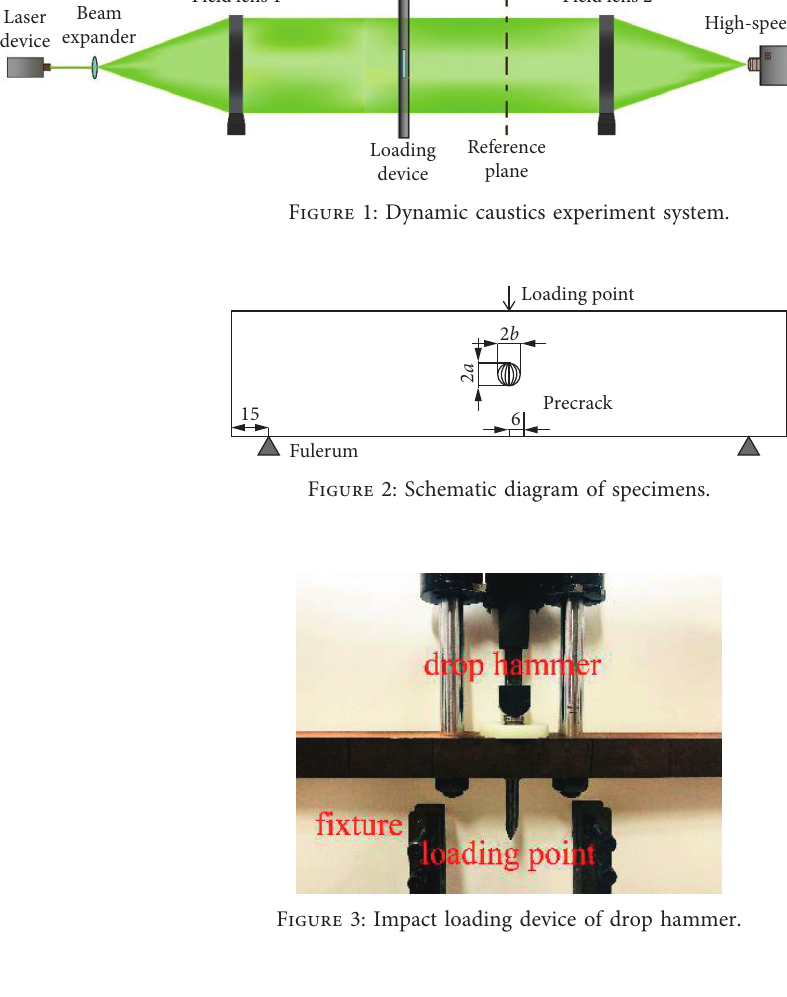
1-1 , (b) S 2-1 , (c) S 3-1 , and (d) S 4-1